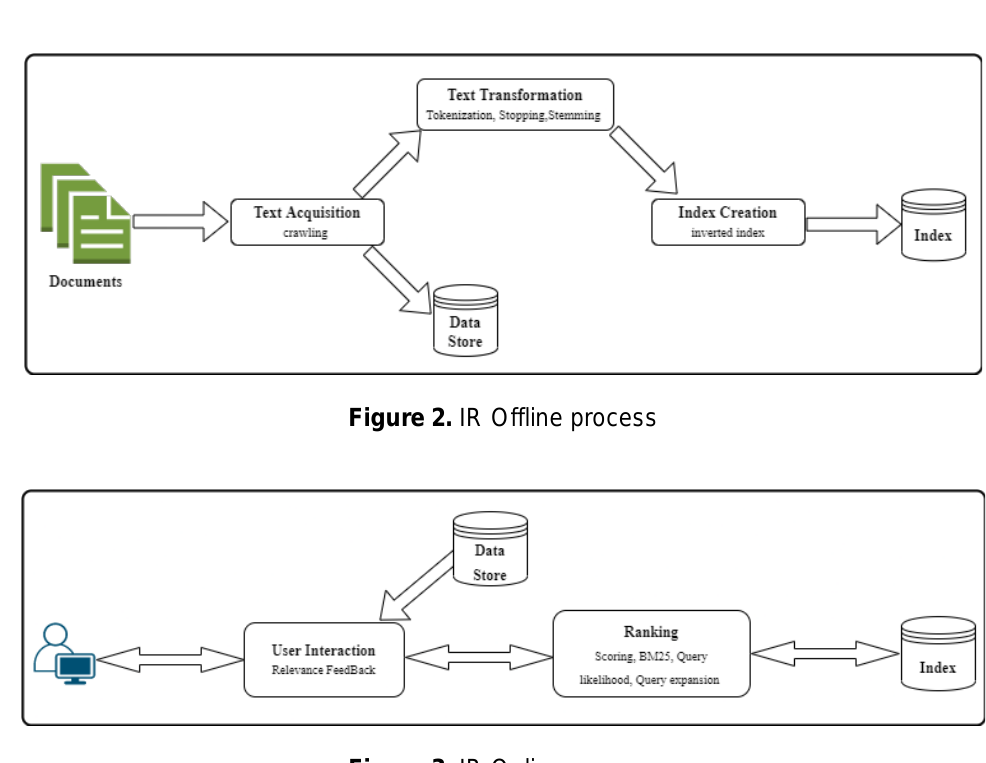
Figure 1. Top ten languages used on the web